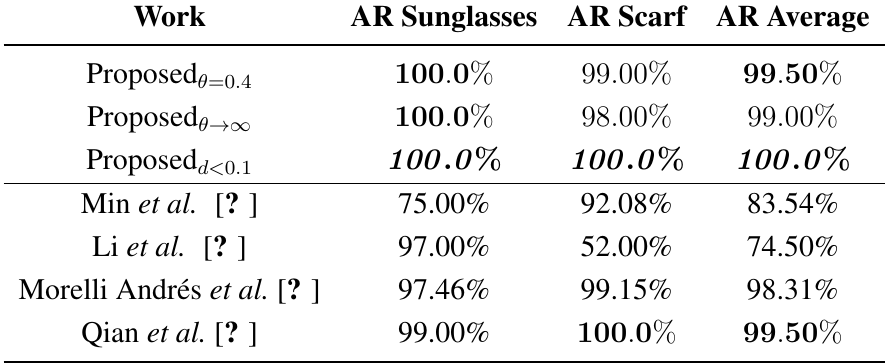
values for the Extended Yale B database and 1